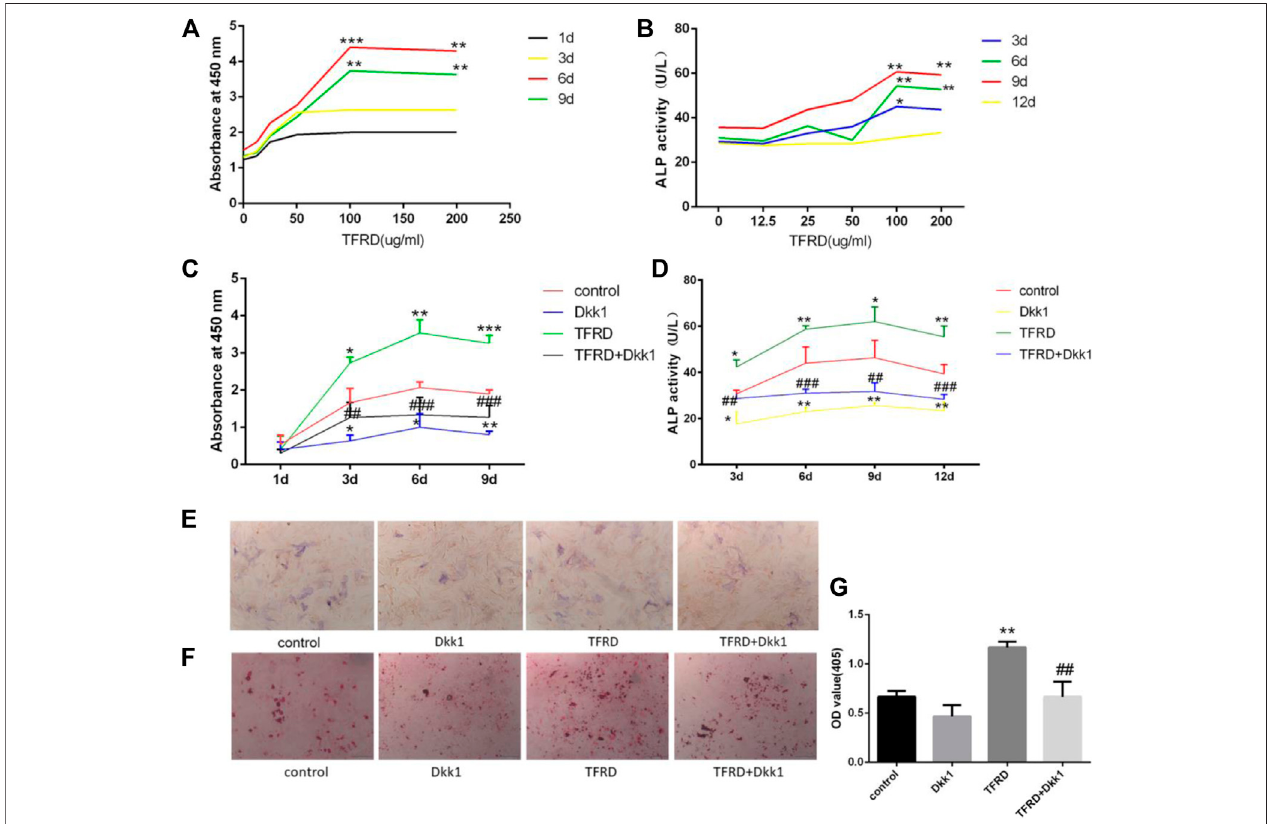
FIGURE 3 | TFRD promotes proliferation and mineralization of osteoblast by Wnt/ β -catenin signaling pathway. (A) is the effect of different concentrations of TFRD on theproliferation ofosteoblastsindifferentperiods.*** p < 0.001,** p < 0.01vs. 0,12.5, 25,50 ug/ml. (B) istheeffect ofdifferentconcentrationsofTFRD ontheactivity of ALP of osteoblasts in different periods. ** p < 0.01, * p < 0.05 vs. 0, 12.5, 25, and 50 ug/ml. (c) is trend and comparison proliferation of osteoblasts in different groups. (D) is activity of ALP of osteoblasts in different groups. (E,F) The ALP and ARS staining of osteoblasts was performed (magni fi cation, × 100). (G) Quantitative determination ofALP activity and theproduction of mineralized nodules. (C – G) N (cid:2) 3/group. Each value was presented as the mean ± SD. *** p < 0.001, ** p < 0.01, * p < 0.05 vs. the control group; ### p < 0.001, ## p < 0.01 vs. the TFRD group.